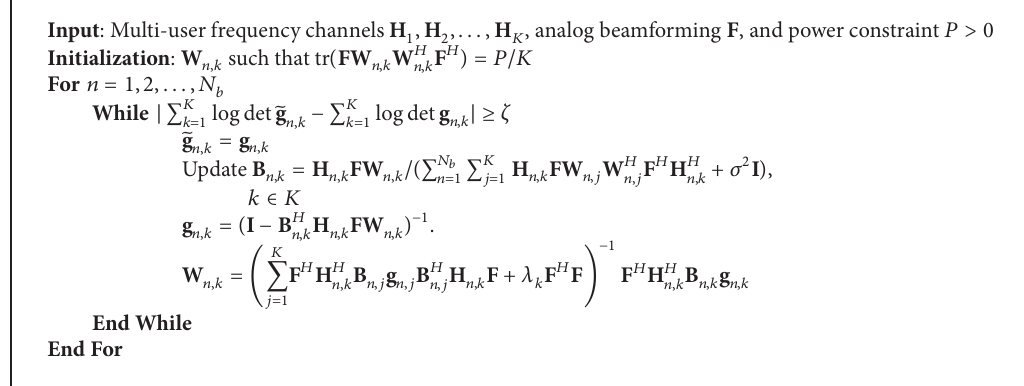
Algorithm 2: Weighted MMSE